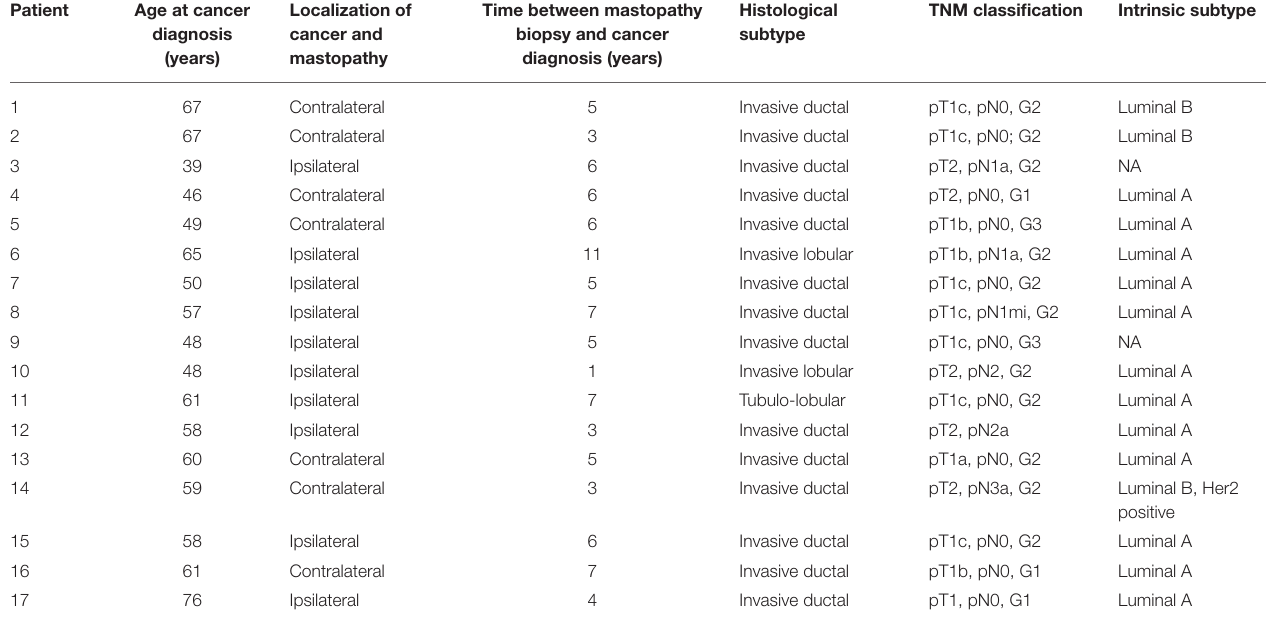
TABLE 1 | Clinicopathological data of the sequenced breast cancer patients.